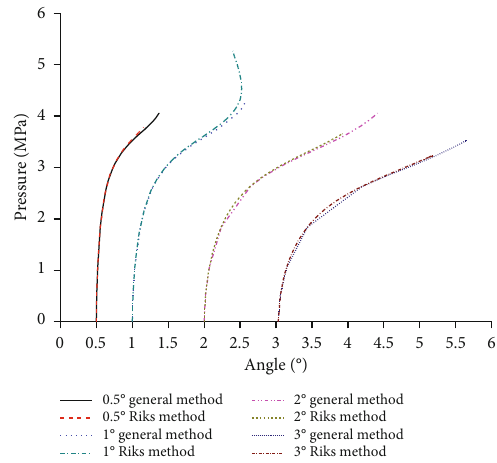
Figure 7: Pressure and swing angle